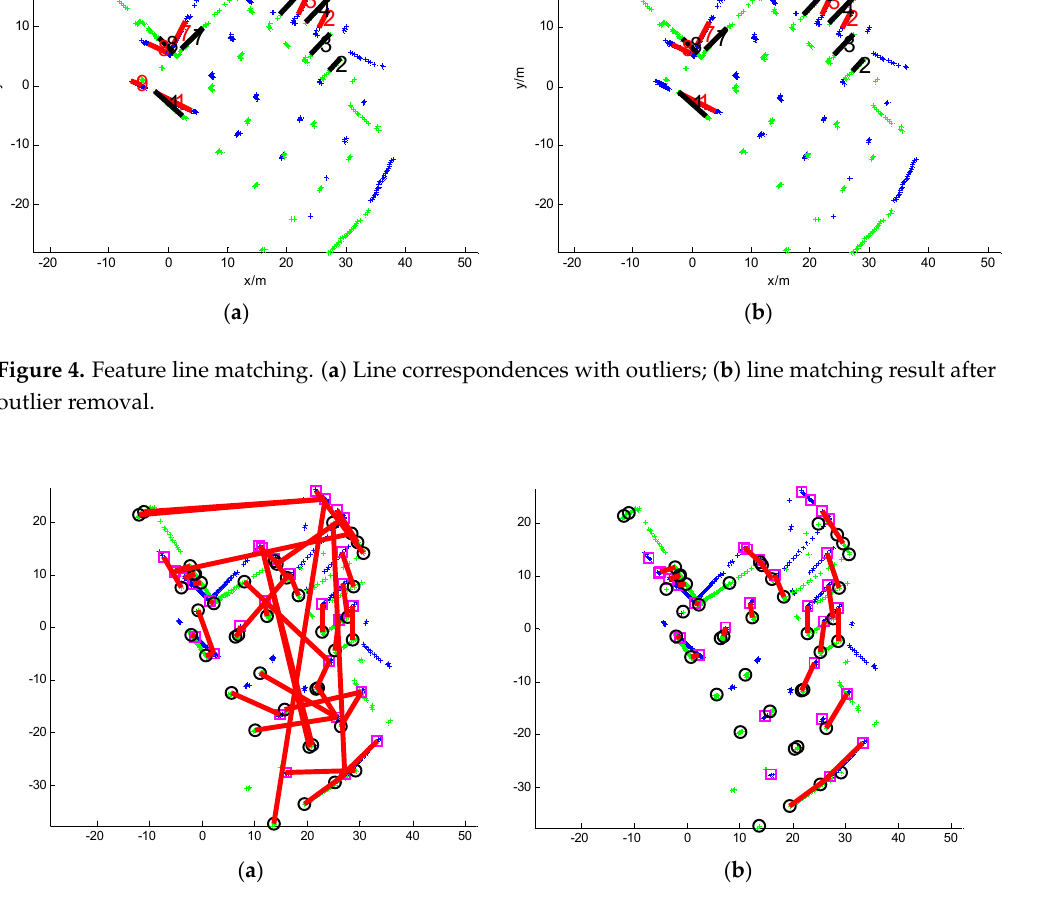
Figure 5. Feature point matching. ( a ) Point correspondences with outliers; ( b ) point matching result after outlier removal.